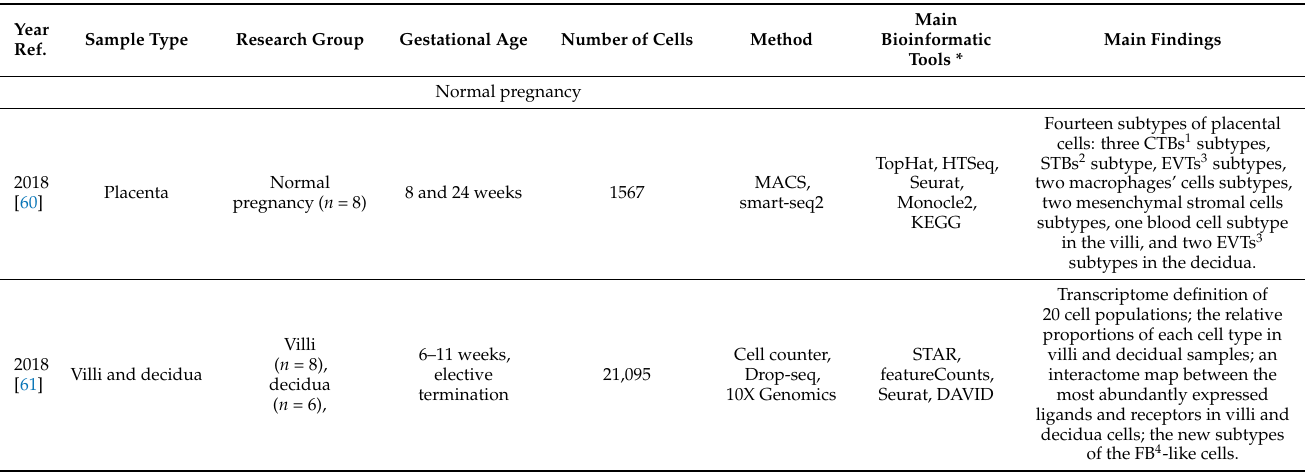
Table 1. The recent discoveries in the studies of normal and pathology pregnancy performed by scRNA-seq